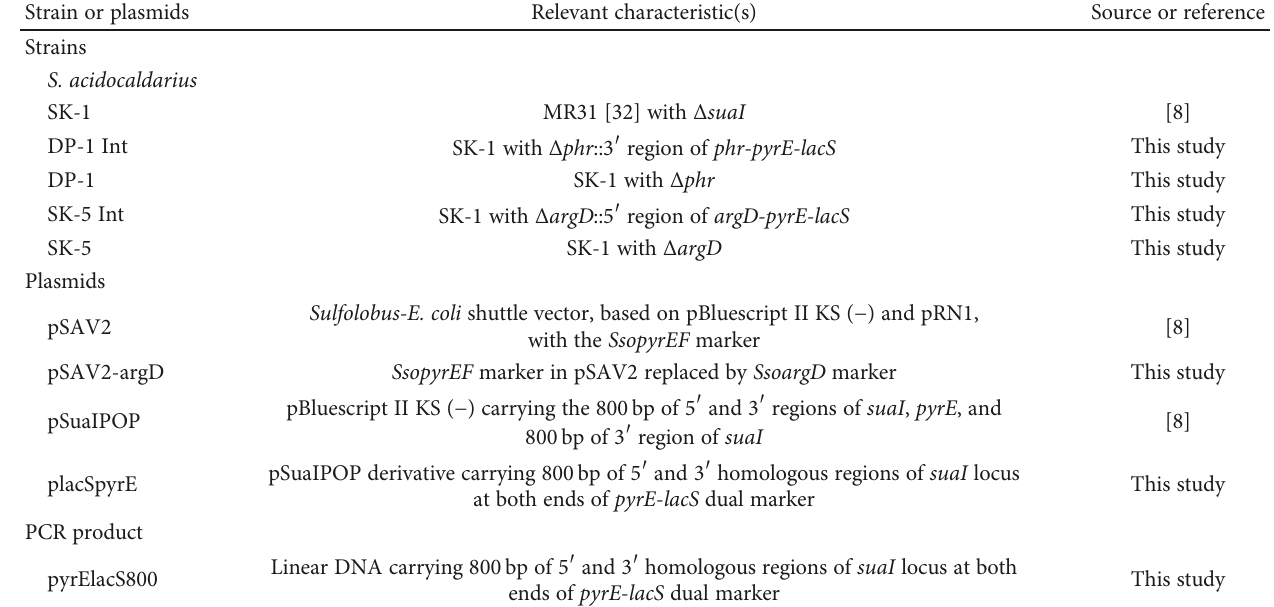
Table 1: Strains and DNA used in this